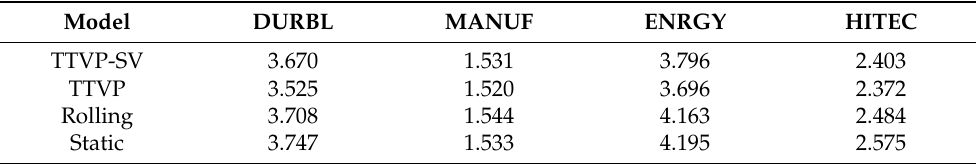
Table 6. In-sample Pricing